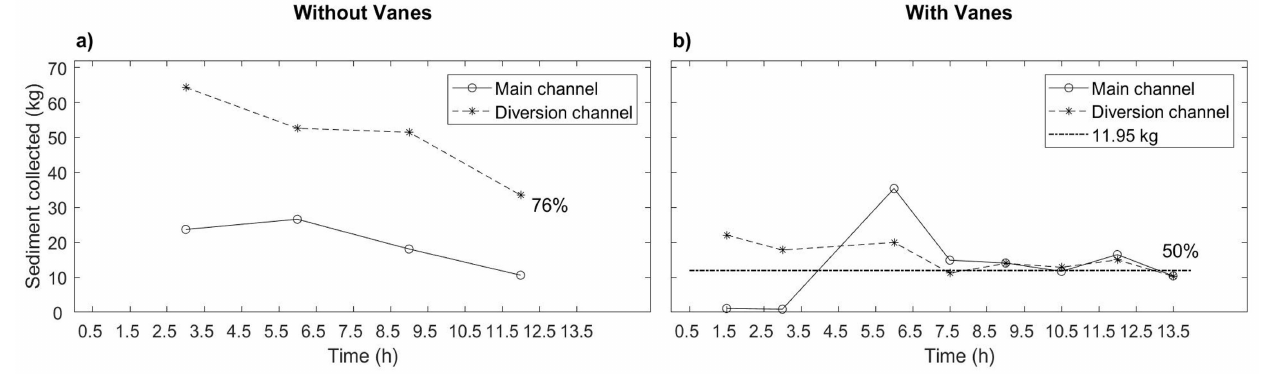
Figure 5. Sediment amounts collected along time: ( a ) in the NV experiment. ( b ) in the VF experiment.